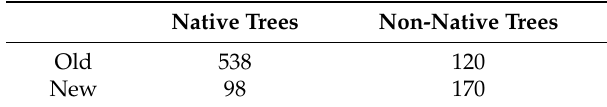
Table A3. Contingency table for test “H” (all neighbourhoods in Halifax).